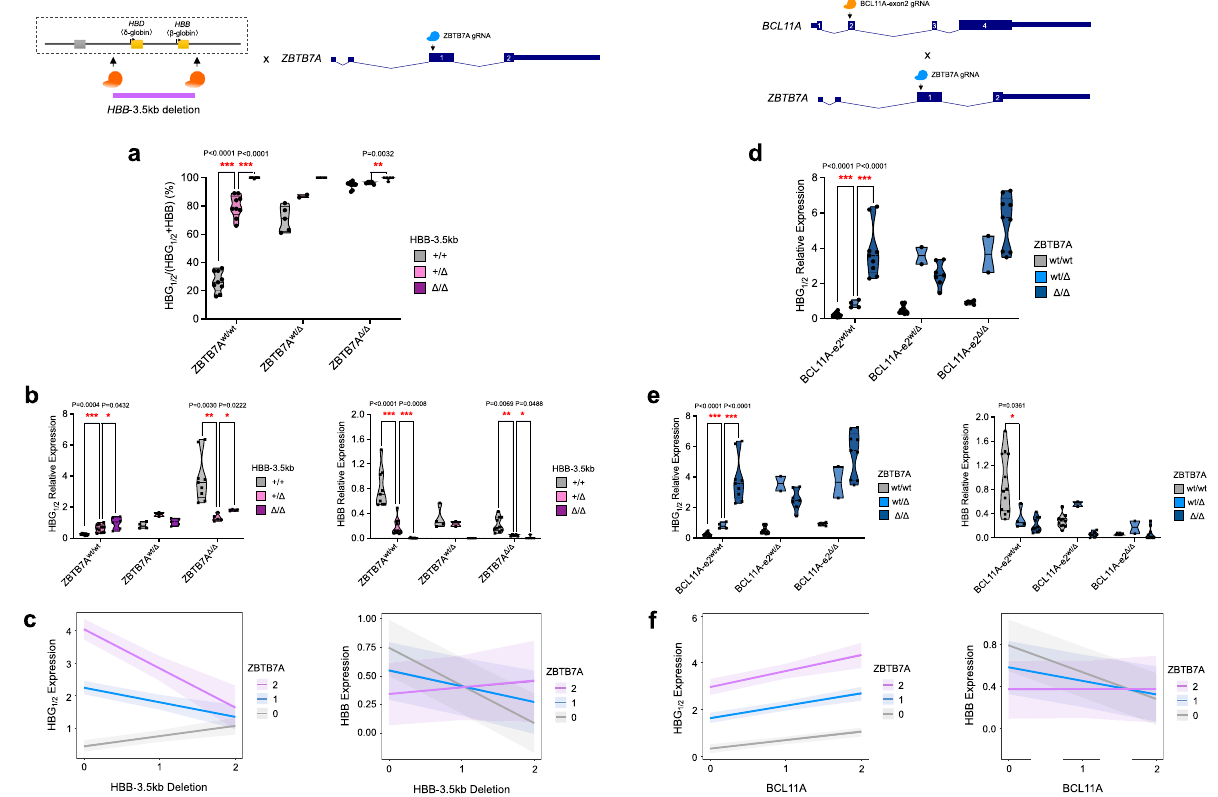
Fig. 3 Functional genetic interactions of ZBTB7A with β -globin locus cis -regulatory element and BCL11A. a , b Globin gene expression analysis in BFU-E colony upon combined perturbation of 3.5kb- HBB element and ZBTB7A. Results are shown as violin plot ( P values are labeled on the top of each comparison. * P < 0.05, ** P < 0.01, *** P < 0.001 by a two-tailed Student ’ s t test). c Quantitative modeling on HBG1/2 or HBB mRNA expression from combined perturbation of HBB- 3.5kb element and ZBTB7A. HBB- 3.5kb deletion (0: + / + ; 1: + / Δ ; 2: Δ / Δ ); ZBTB7A mutation (0: ZBTB7A wt/wt ; 1: ZBTB7A wt/ Δ ; 2: ZBTB7A Δ / Δ ). Modeling lines and bands are shown as mean± 95% CI. d , e Globin gene expression analysis in BFU-E colony upon combined perturbation of BCL11A and ZBTB7A. BCL11A-e2 Δ : frameshift mutation in BCL11A exon 2; ZBTB7A Δ : frameshift mutation in ZBTB7A. Results are shown as violin plot ( P values are labeled on the top of each comparison. * P < 0.05, *** P < 0.001 by a two-tailed Student ’ s t test). f Quantitative modeling on HBG1 / 2 or HBB mRNA expression from combined perturbation of BCL11A and ZBTB7A. BCL11A mutation (0: BCL11A wt/wt ; 1: BCL11A-e2 wt/ Δ ; 2: BCL11A-e2 Δ / Δ ); ZBTB7A mutation (0: ZBTB7A wt/wt ; 1: ZBTB7A wt/ Δ ; 2: ZBTB7A Δ / Δ ). Modeling lines and bands are shown as mean ± 95%